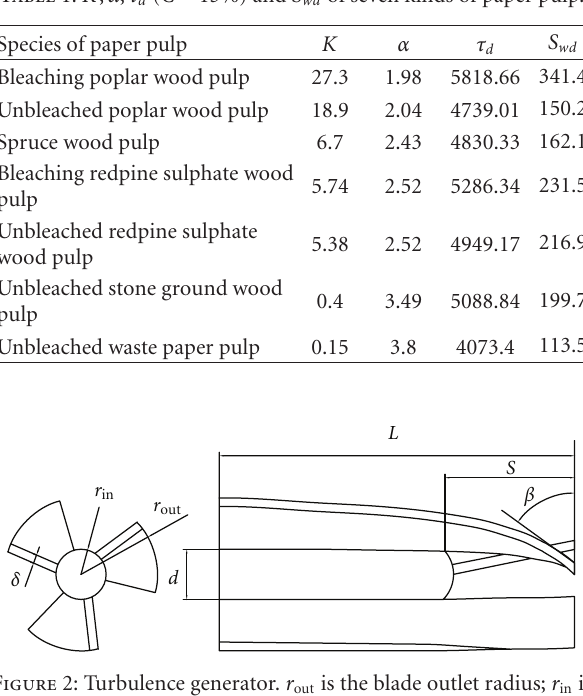
Table 1: K , α , τ d ( C = 15%) and S wd of seven kinds of paper pulp.